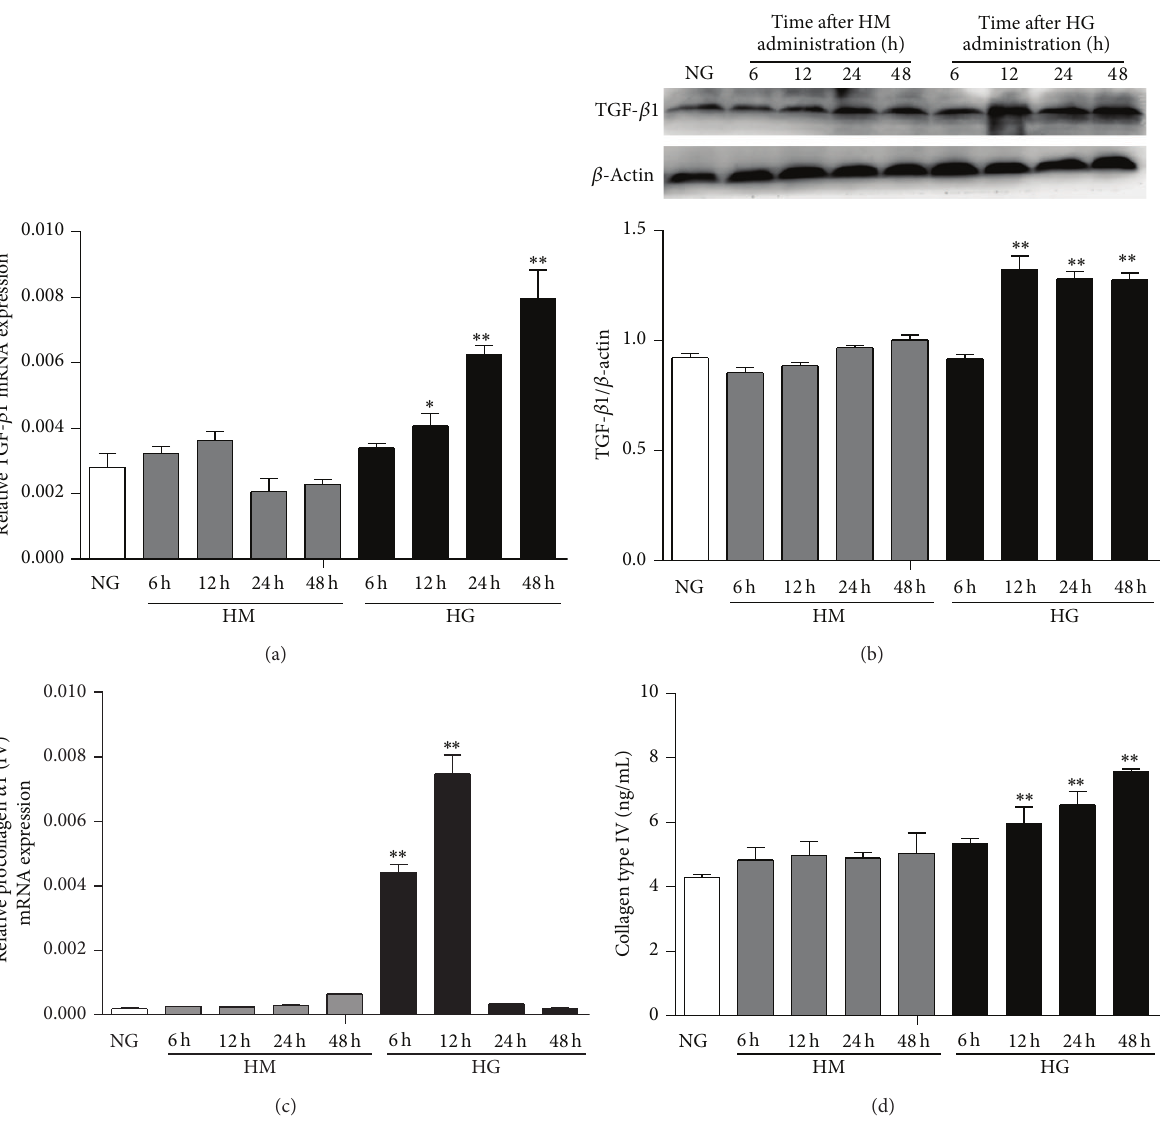
Figure 4: Effect of HG on mRNA and protein levels of TGF- 𝛽 1 and collagen type IV in MMCs over time. MMCs were cultured in media containing NG and then stimulated with HM or HG for 6, 12, 24, and 48 h. (a) and (c) RT-PCR analysis of mRNA levels of TGF- 𝛽 1 and collagen type IV, respectively. (b) Western blot analysis of protein level of TGF- 𝛽 1. (d) ELISA of secretion of collagen type IV. Data are mean ± SEM. ∗ 𝑃 < 0.05 , ∗∗ 𝑃 < 0.01 versus NG. Table 2: Metabolic data of mice in different groups by